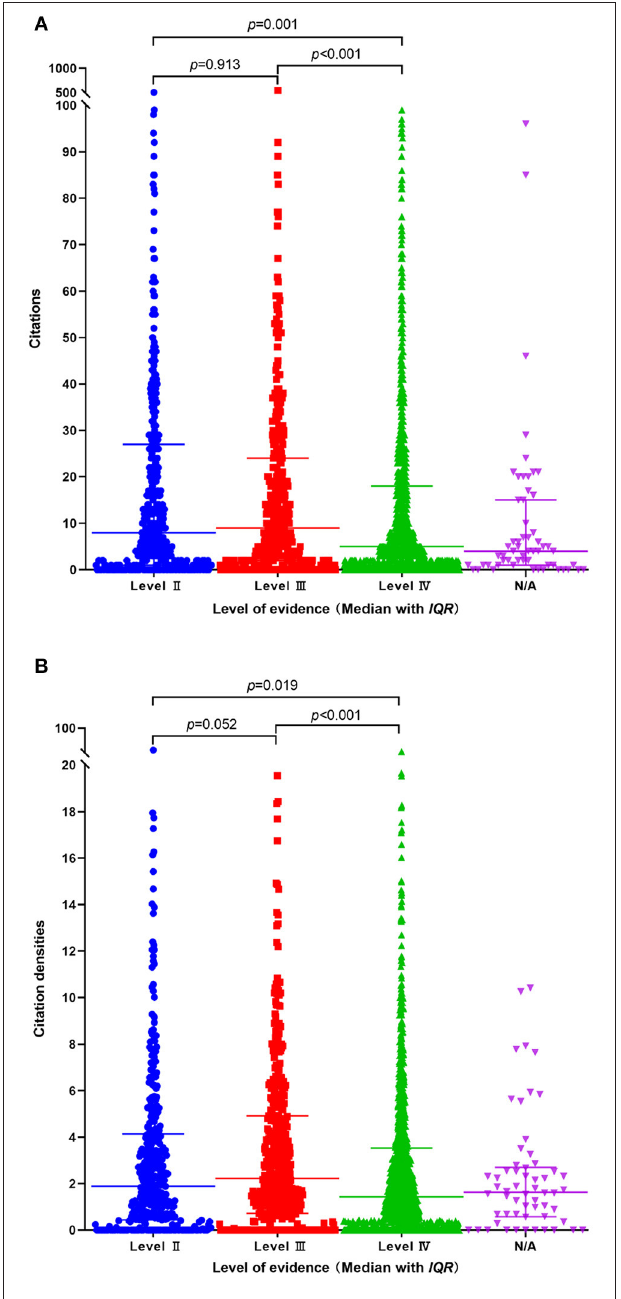
FIGURE 5 | Comparison of citations and citation density between different levels of evidence. (A) citations. (B) citation